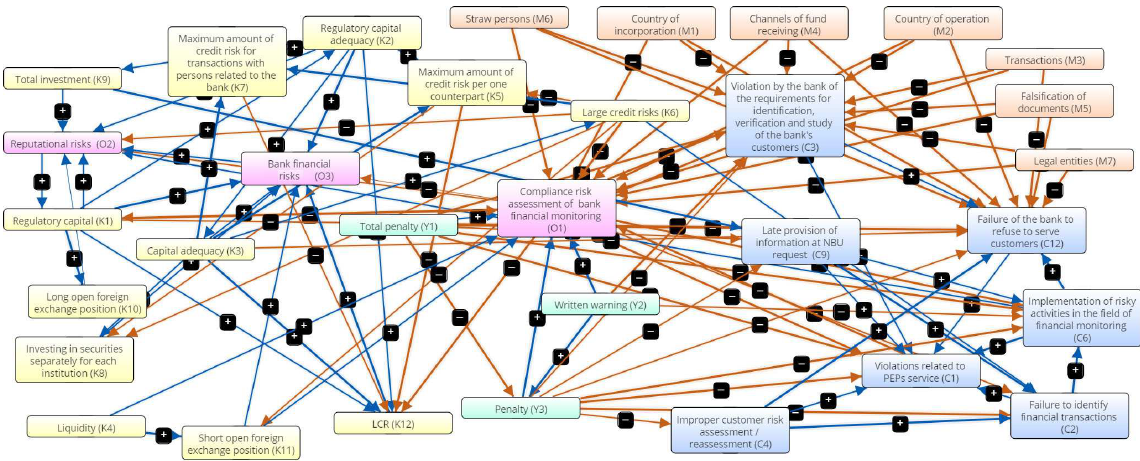
Figure A1. Cognitive map of acceptance criterion variability applicable to banks acting as pension custodians in light of the counterparties’ expectations for non-state pension provision, taking into account the impact factors (violations and measures of financial monitoring, regulations of the National Bank of Ukraine and the likelihood of the network schemes by bank